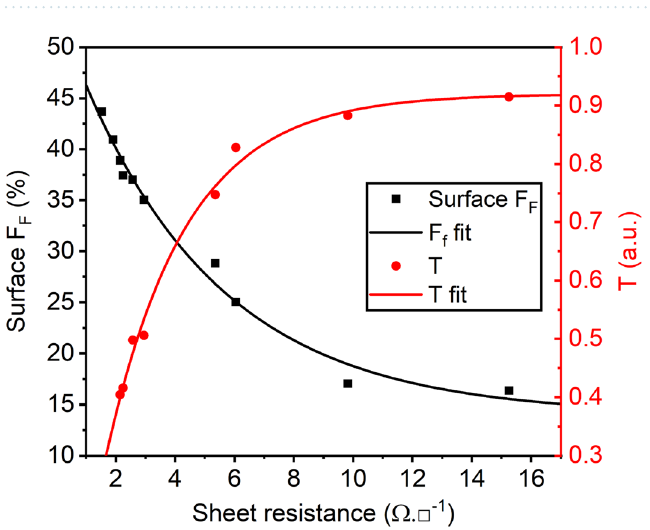
Figure 4. Optical transmittance and haze of the TCEs ( a ) Transmittance spectrum for samples with 1–4 nanowire layers (left axis). The haze characteristics of the sample with 2 layers before and after photonic treatment (dashed lines—right axis) ( b ) Surface coverage fill factor F F from 1 to 10 layers of deposited nanowires. Inset: SEM image of a 2-layer sample.